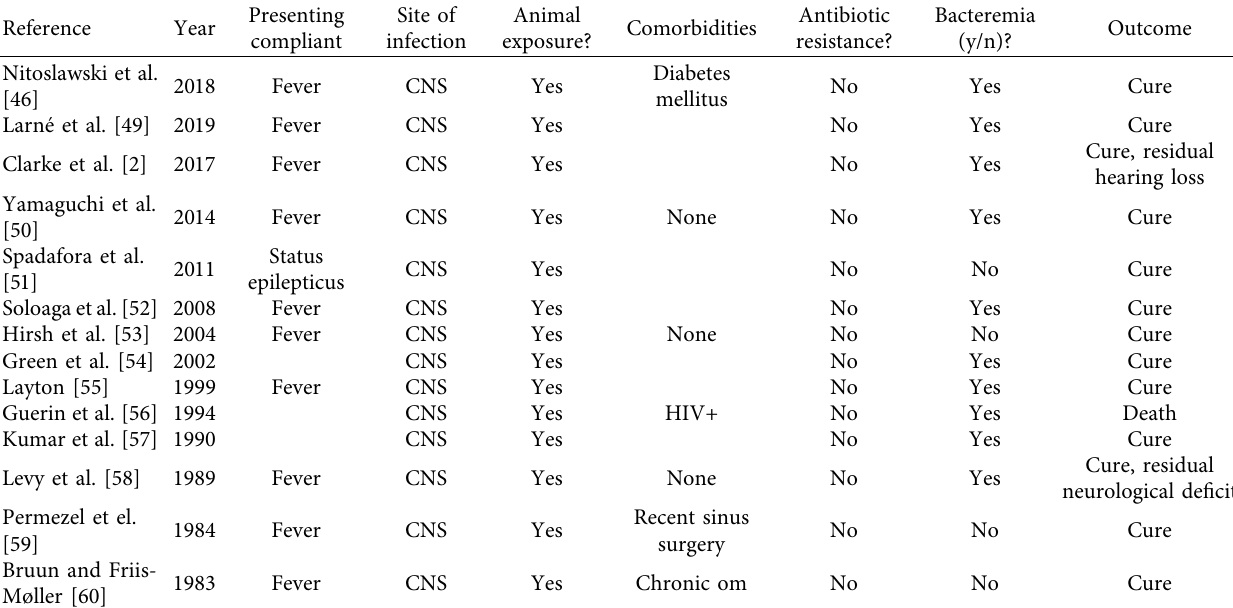
Table 3: Previous findings and outcomes from case reports in relation to the presence of meningitis in patients with Pasteurella bacteremia.